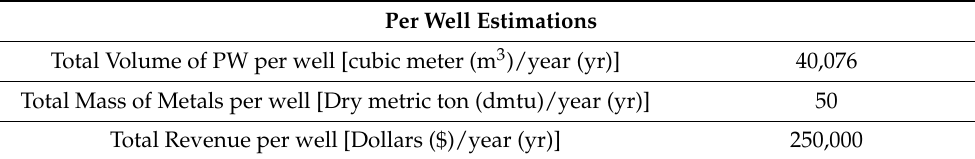
Table 3. Well Estimations for Texas (Permian Basin).